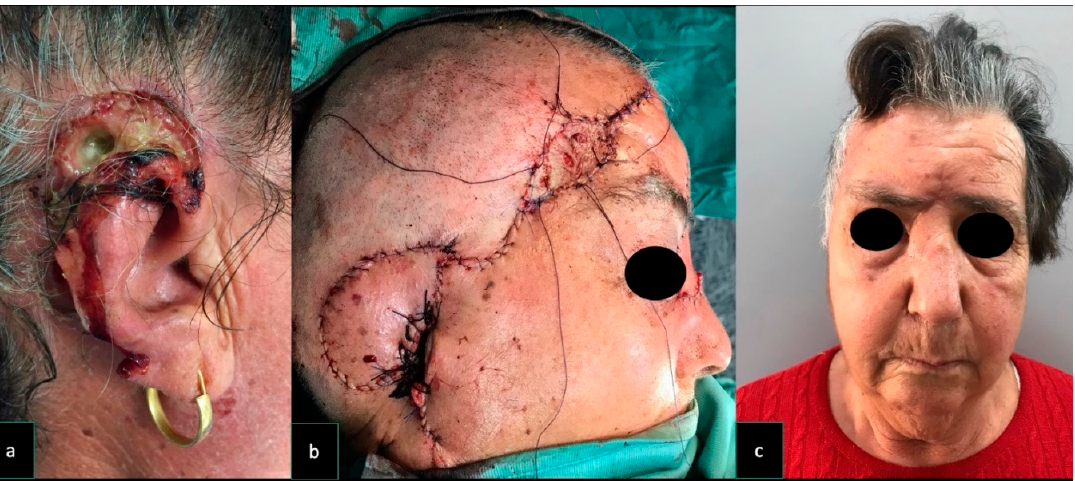
Figure 3. Case 2. A 76-year old woman underwent excisions for a squamous cell carcinoma involving the external ear and mastoid area A pedicle superficial temporal artery flap (9 × 7 cm) was raised and used to reconstruct the ear defect. The flap donor site was repaired with a skin graft and a local advancement flap was harvested to reduce the skin graft size. At 6-months follow-up, the patient was pleased with the aesthetic result and was disease free. ( a ) Pre-operative appearance of a cancer involving external ear and mastoid area. ( b ) The reconstruction performed with STAP flap; the donor site was skin grafted. ( c ) Post-operative symmetric appearance of the brows at